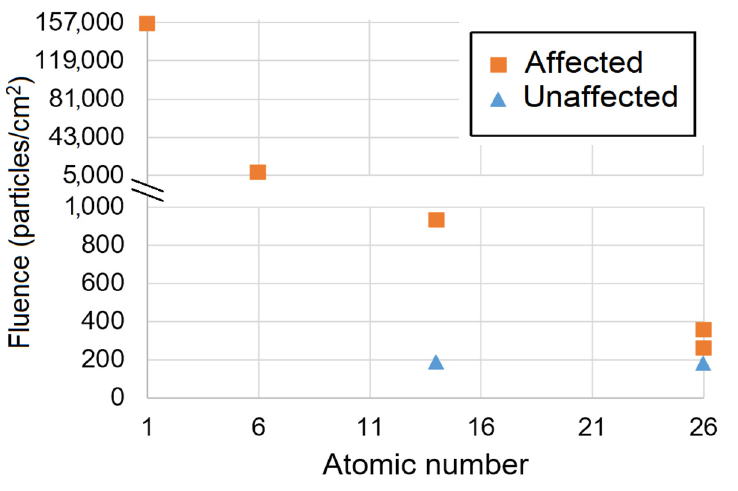
Figure 4. Effect of heavy charged particle’s fluence on adult neurogenesis. The graph shows cases of impaired neurogenesis (marked as “Affected”), as well as the lack of influence on neurogenesis (marked as “Unaffected”).